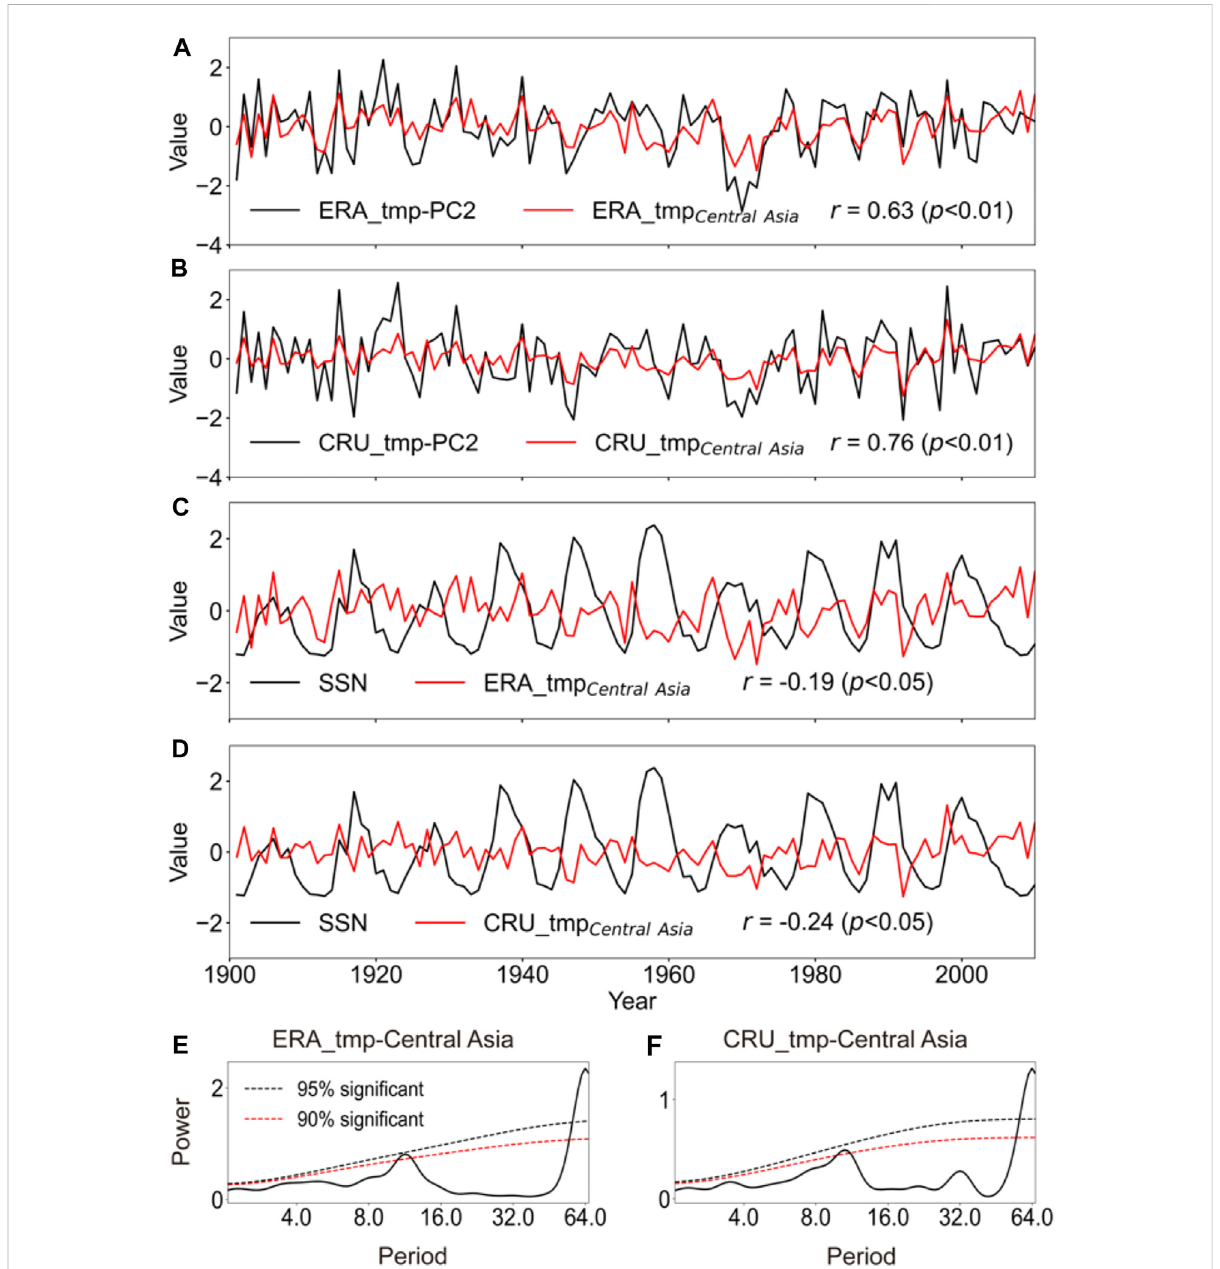
FIGURE 5 Comparison ofthetemperature ofCentralAsia(30 ° N – 60 ° Nand50 ° E – 90 ° E)andPC2 (A,B) andSSN (C,D) , (E,F) Powerspectrumofthesummer temperature for Central Asia. The red and black dashed lines indicate statistical con fi dence at the 90% and 95% con fi dence